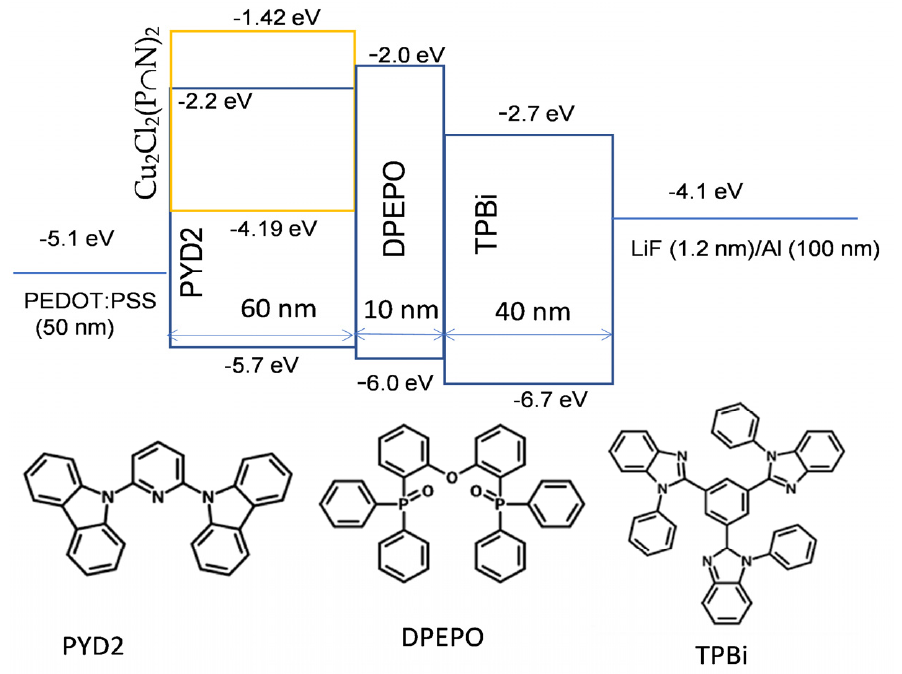
of Cu 2 Cl 2 (P ∩ N) 2 could effectively trap holes injected from the PEDOT:PSS layer. The efficiency of Cu 2 Cl 2 (P ∩ N) 2 -based devices is limited by the relatively low PLQY of thin films, which is slightly dependent on the dopant concentration. With concentration increase from 4 to 8 wt %, PLQY increases from 19% to 27% (at λ exc = 360 nm), probably because the increased doping concentration leads to an increase of the environment rigidity. Nonethe- less, the simple device structure and the ultra-broad electro-luminescence (EL) spectra with full width at half maximum (FWHM) of 153 nm make these studies attractive. One obtains a yellowish white emission with CIE coordinates of (0.38, 0.49) and a color rendering index (CRI) of 64 in the device with 8 wt % of Cu 2 Cl 2 (P ∩ N) 2 . With the participation of the host emission, the device with 2 wt % Cu 2 Cl 2 (P ∩ N) 2 gives an improved white color with CIE coordinates of (0.38, 0.45) and CRI of 72. By improving the PLQY of the films and by further optimizing the device structure, dimeric copper(I) emitters featuring combined TADF and phosphorescence may find wide application in future low-cost WOLEDs.